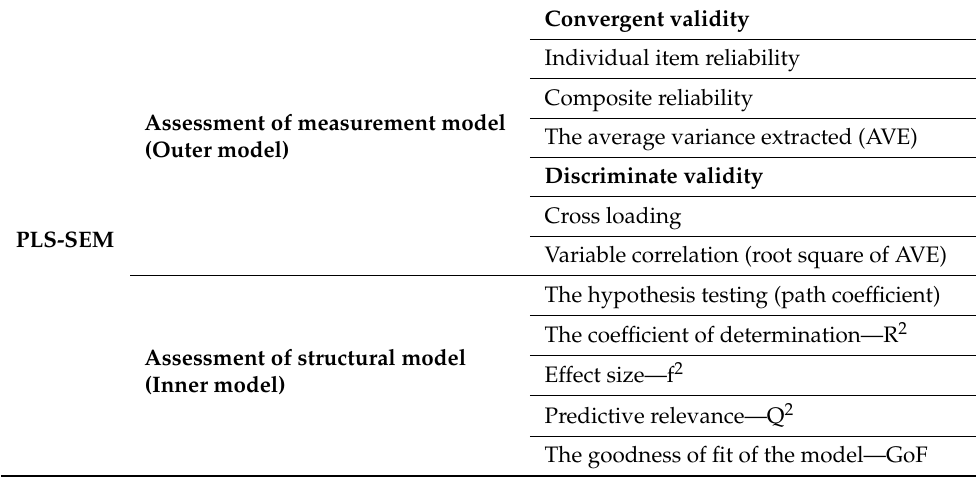
Table 2. Data analysis steps using the PLS-SEM method.